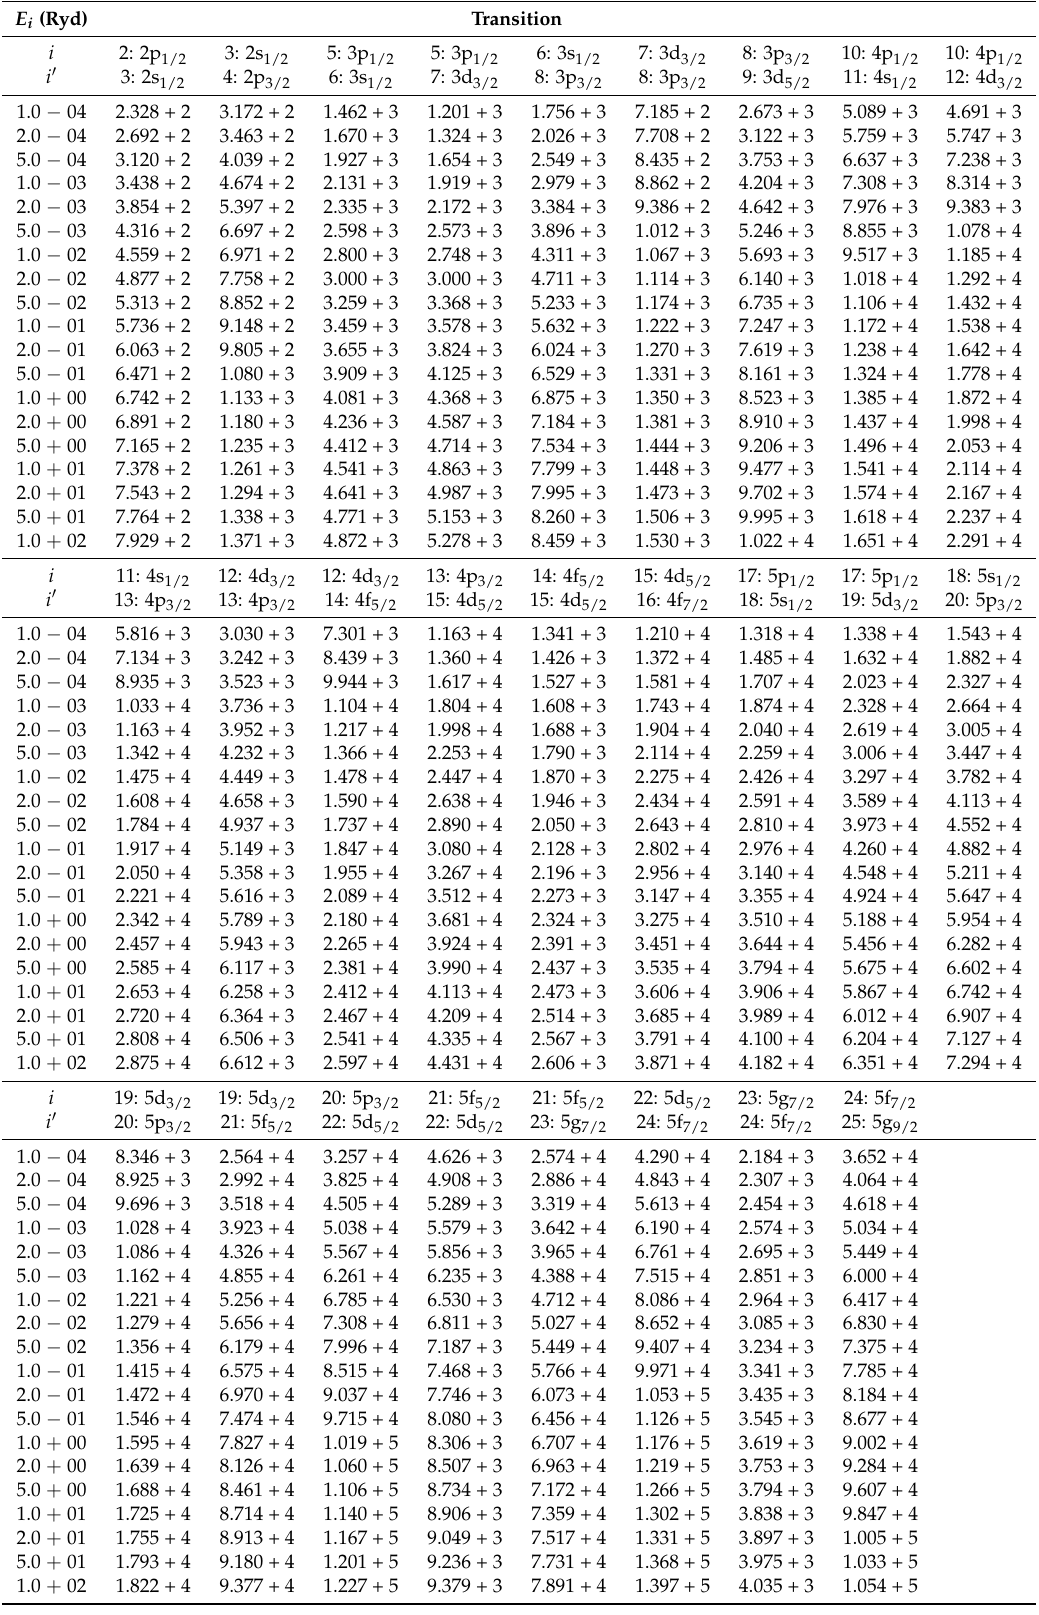
Table 2. Collision strengths for transitions of atomic hydrogen as a function of energy. a ± b ≡ a × 10 ± b . E i (Ryd)